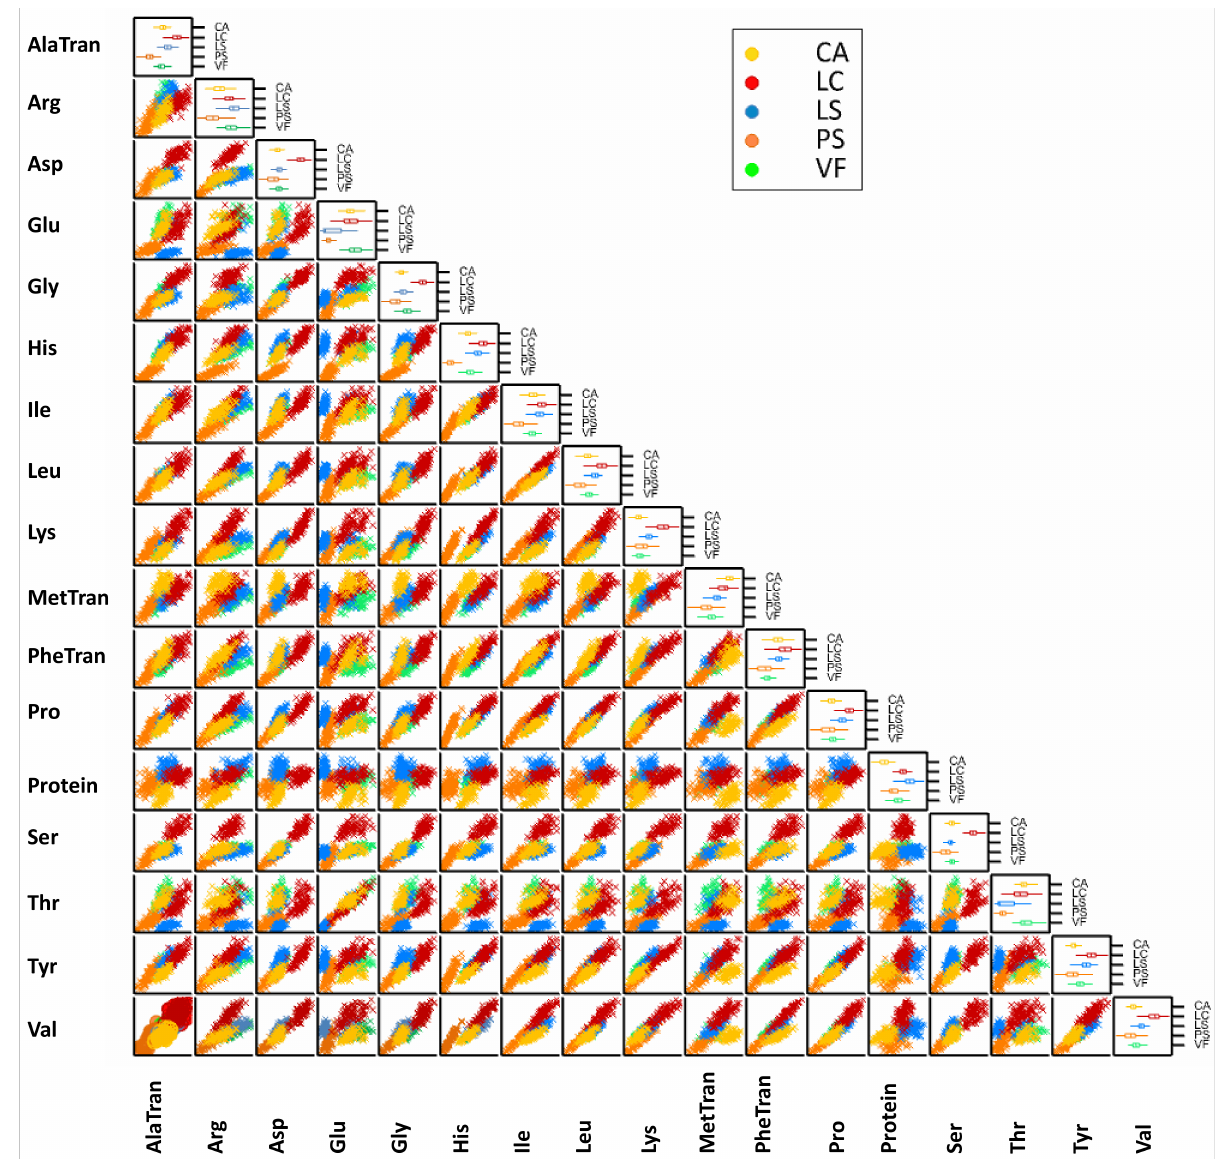
Figure 2. Scatter plot matrix showing the pairwise relationships between traits and in the di- agonal, the box plots showing the data trait distribution for each species. Legend: in yellow, Cicer arietinum (CA), n = 86; in red, Lens culinaris (LC), n = 92; in blue, Lathyrus sativus and their crop wild relatives (LS), n = 109; in orange, Pisum sativum and their crop wild relatives (PS), n = 118; and in green, Vicia faba (VF), n = 92. Traits’ legend: AlaTran—Alanine transformed values, Arg—Arginine, Asp—Aspartic acid, Glu—Glutamic acid, Gly—Glycine, His—Histidine,